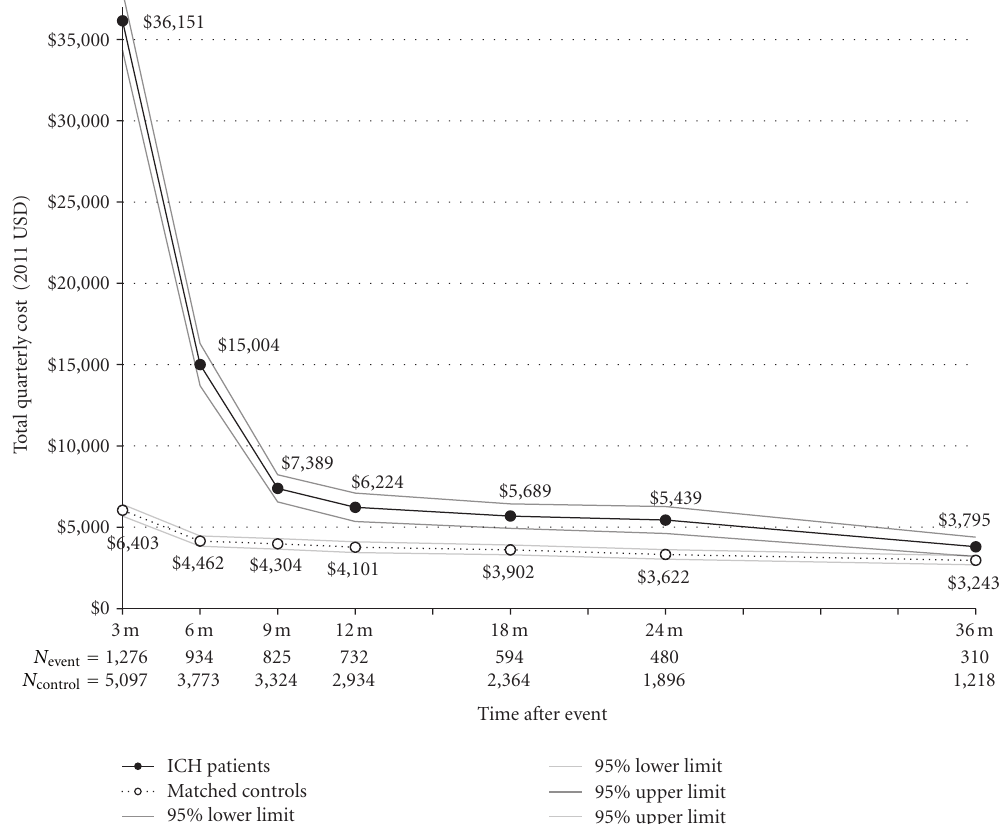
Figure 2: Total quarterly cost for Medicare patients with NVAF with and without ICH. Note: P < 0 . 01 for di ff erence in costs between patients with events and matched controls at all-time points using t -test assuming unequal variances and α = 0 . 05 level.